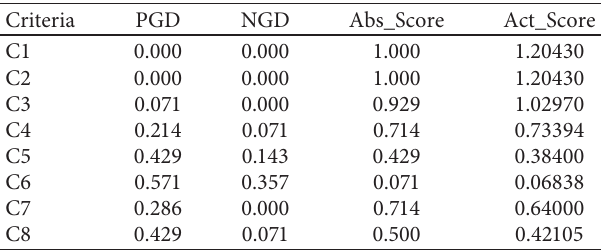
Table 7: Absolute and actual scores of respective PFNs repre- senting the criteria.